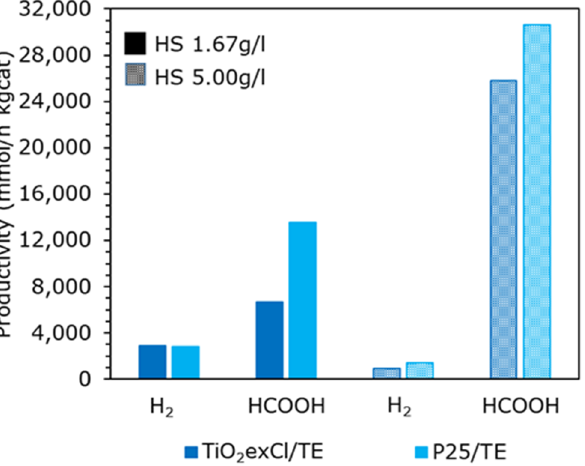
Figure 6. The effect of hole scavenger concentration on product distribution and productivity at 18 bar with pH = 14, 31 mg/L of photocatalyst, and 1.67 g/L or 5.00 g/L of HS concentration; reaction time 24 h.